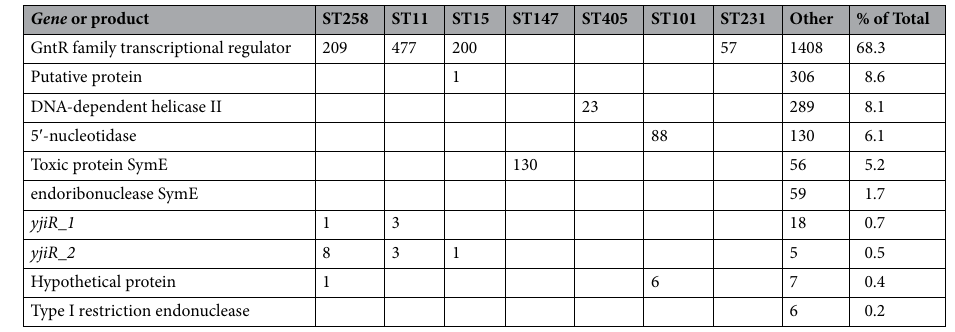
Table 4. Genes and proteins encoded by coding sequences immediately downstream on opposite strand of chromosomal fosA . Together these account for 99.6% of downstream elements in 3584 K. pneumoniae samples. For a given MLST, all samples normally have the same gene downstream of fosA . Genes yjiR_1 and yjiR_2 are truncated versions of the GntR family transcription regulator.